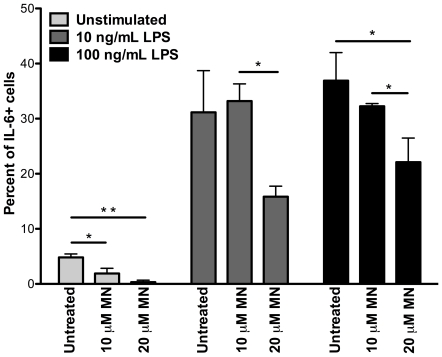
Minocycline treatment inhibits induction of IL-6 by CD14+ monocytes in vitro.CD14+ monocytes were cultured in non-adherent conditions with M-CSF and in the presence or absence of minocycline for 16 hours. IL-6 was induced by LPS in the presence of brefeldin A for 3 hours. The percentage of monocytes producing IL-6 was significantly lower with 10 µM (p = 0.04) and 20 µM (p = 0.009) minocycline than in untreated cells. With 10 ng/mL LPS, the percent of IL-6 producing monocytes was significantly reduced with 20 µM as compared to 10 µM minocycline treatment (p = 0.016). With 100 ng/mL LPS stimulation, minocycline treatment at both 10 µM (p = 0.058) and 20 µM (p = 0.03) doses significantly inhibited IL-6 cytokine secretion in CD14+ monocytes. Data presented represent the results of two independent experiments with n = 3 animals per experiment performed in triplicate wells. P values were determined using a Mann-Whitney U test.